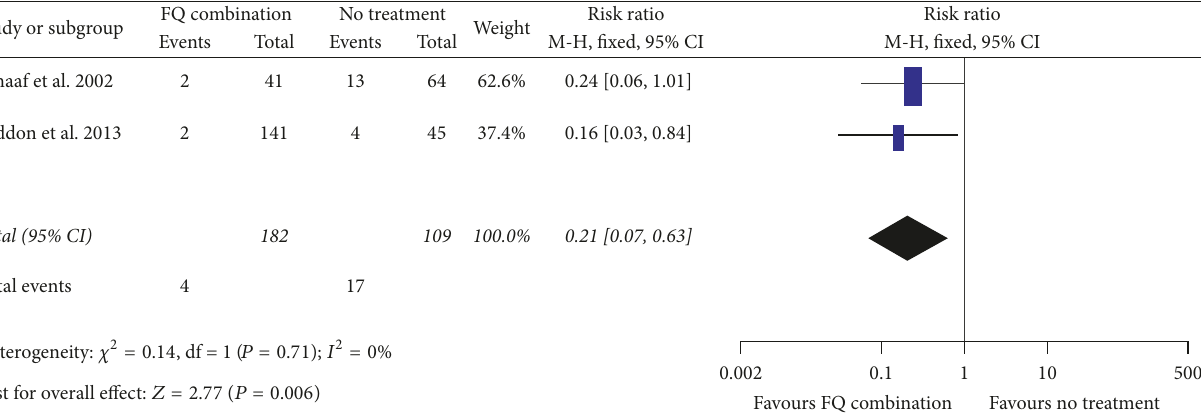
Figure 2: Forest plot of comparison of effect of preventive therapy versus no therapy for pediatric contacts of MDR-TB patients.